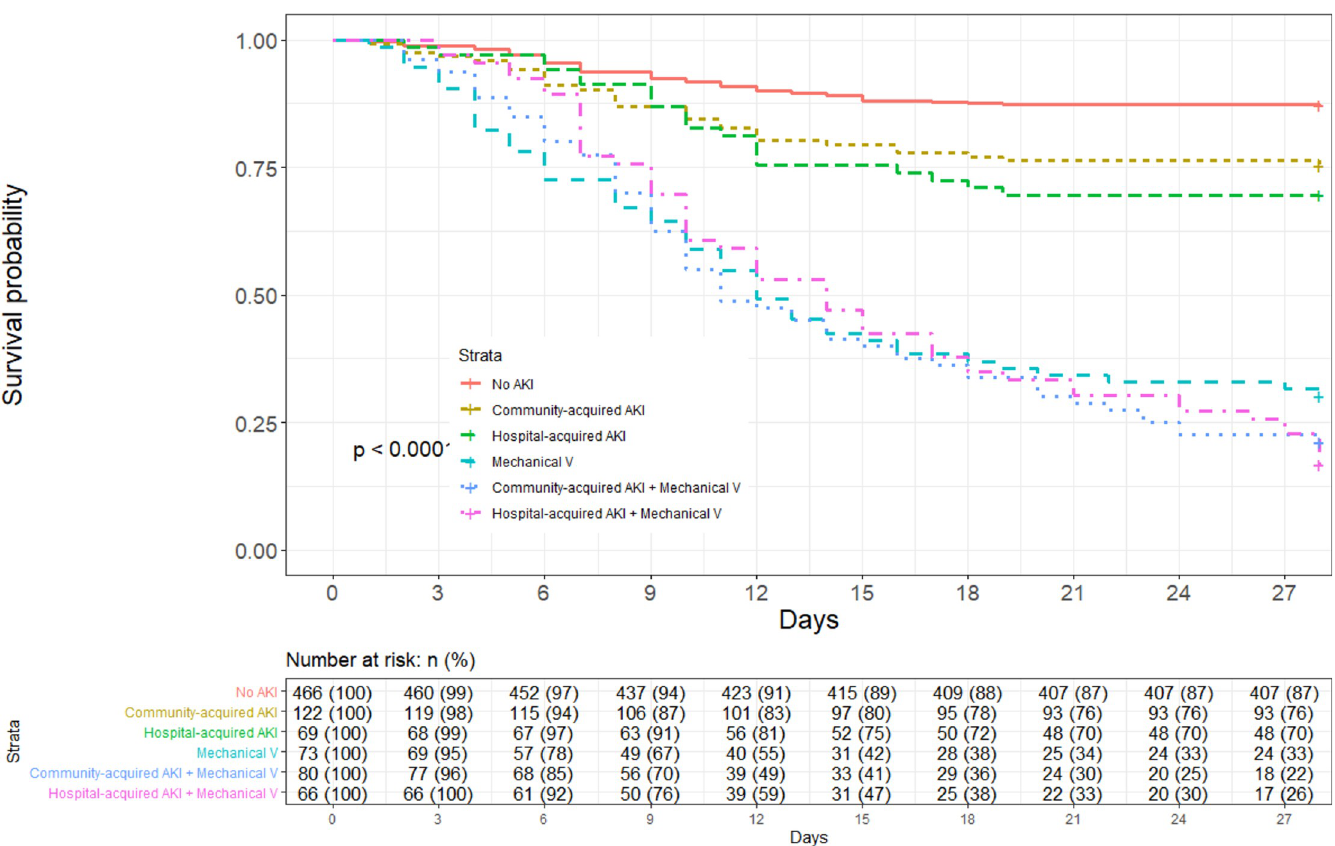
Fig 2. Kaplan–Meier survival statistics comparing community-acquired AKI, hospital-acquired AKI, and mechanical ventilation. Numbers of patients at risk at each time point shown below the graph.